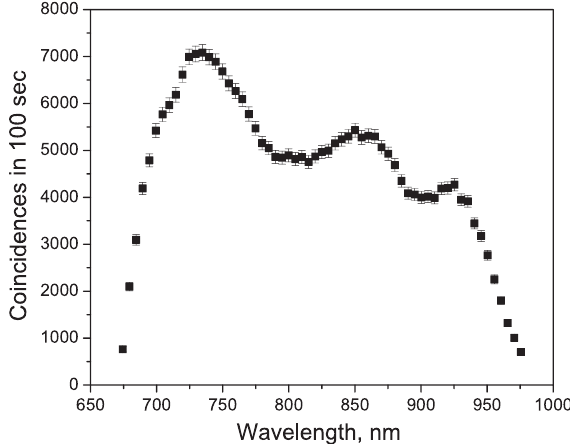
FIG. 2. Images of the plasmonic nanoparticle array on a PDMS substrate. (a) Dark-field microscope image at 10 × magnification. FIG. 3. Spectrum of coincidences of SPDC from three BBO crystals. The error bars are the standard